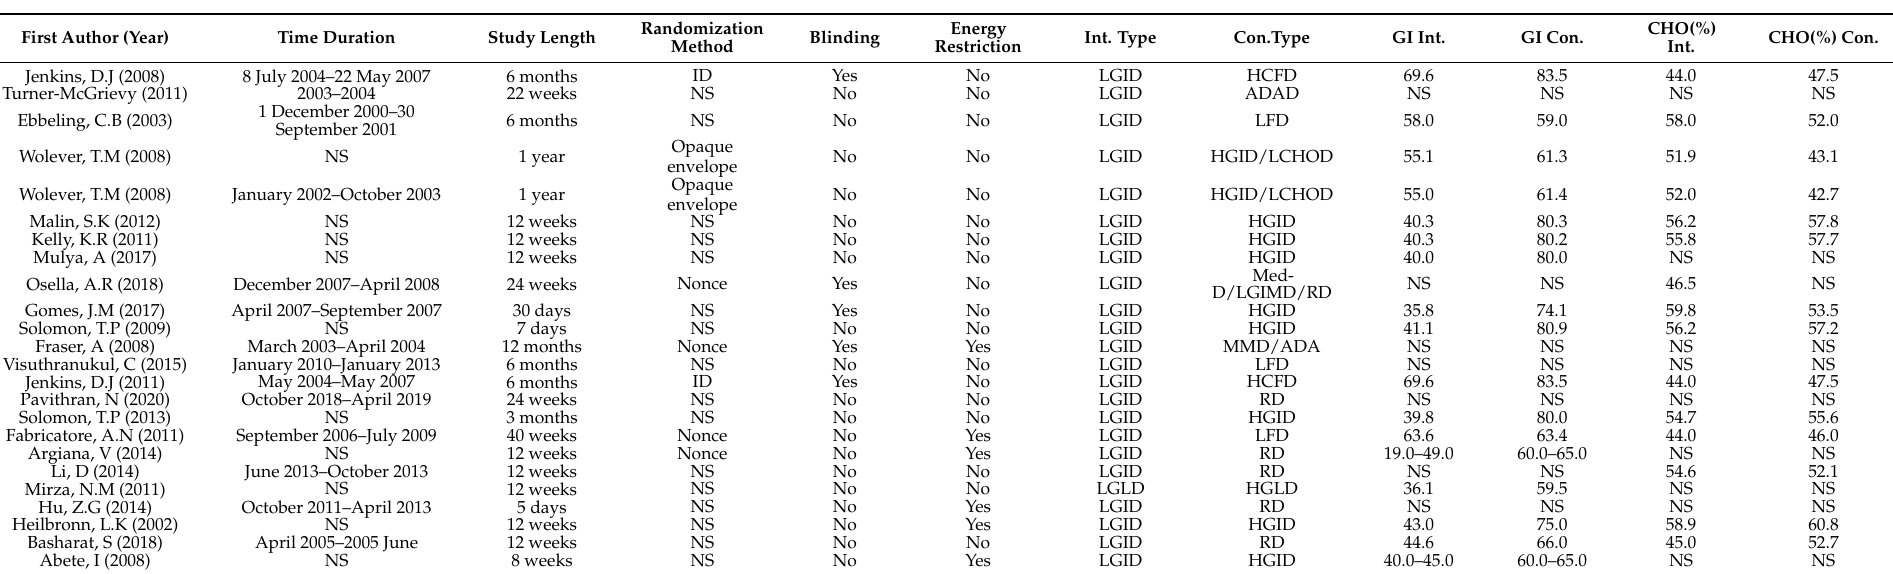
Table 2. RCT-related characteristics of the included